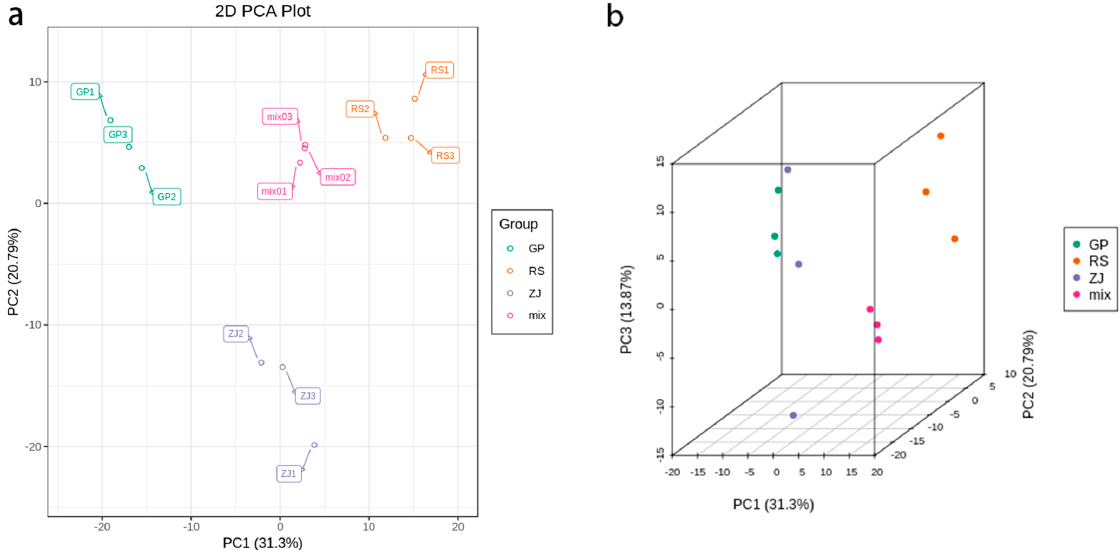
Figure 2. Score plot of PCA for D. officinale samples: ( a ) 2D score plot of PCA for D. officinale samples originate from GP, ZJ, RS, and MIX samples. PC1 represents the first principal component, and PC2 represents the second principal component. ( b ) 3D score plot of PCA for D. officinale samples originate from GP, ZJ, RS, and MIX samples. PC3 represents the third principal component.